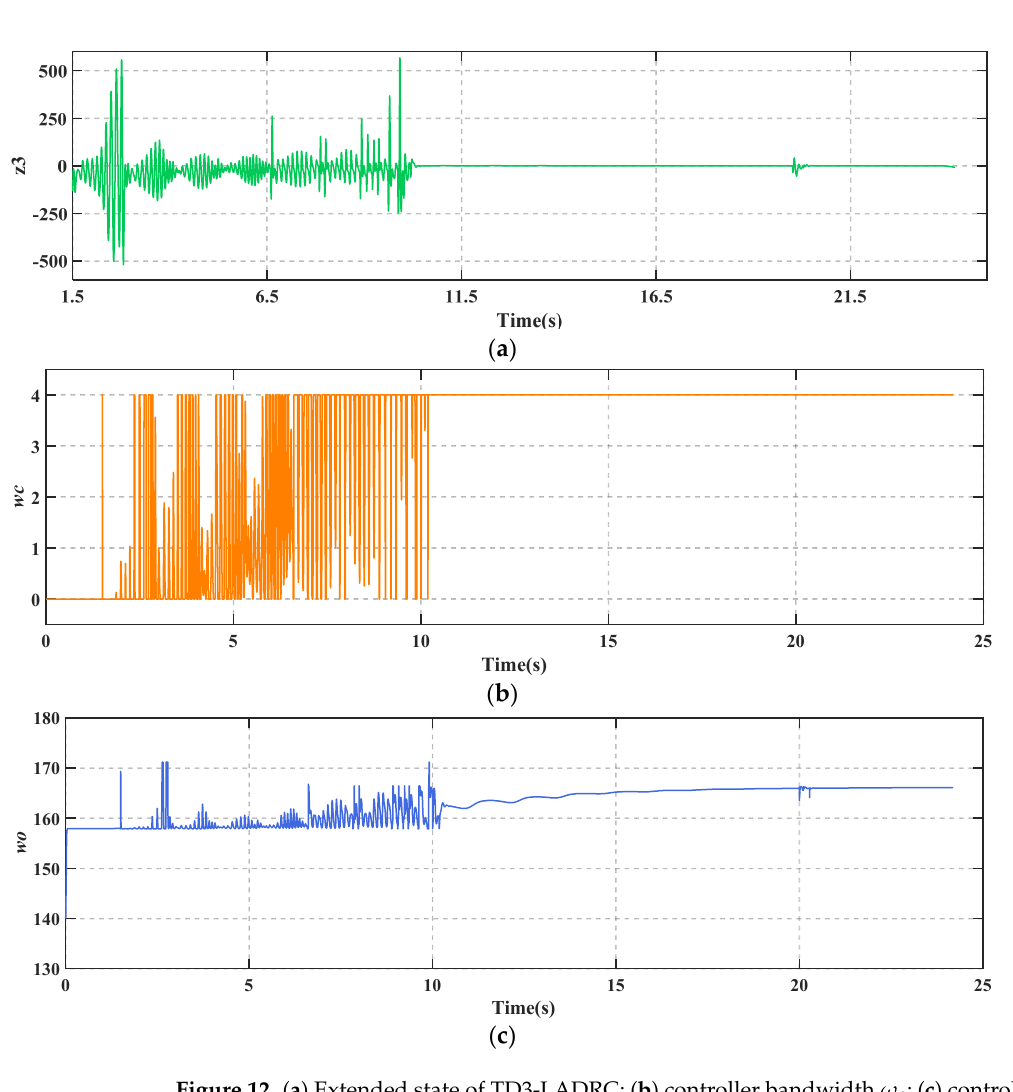
Figure 12. ( a ) Extended state of TD3-LADRC; ( b ) controller bandwidth ω c ; ( c ) controller bandwidth ω o . Table 10. AABS performance